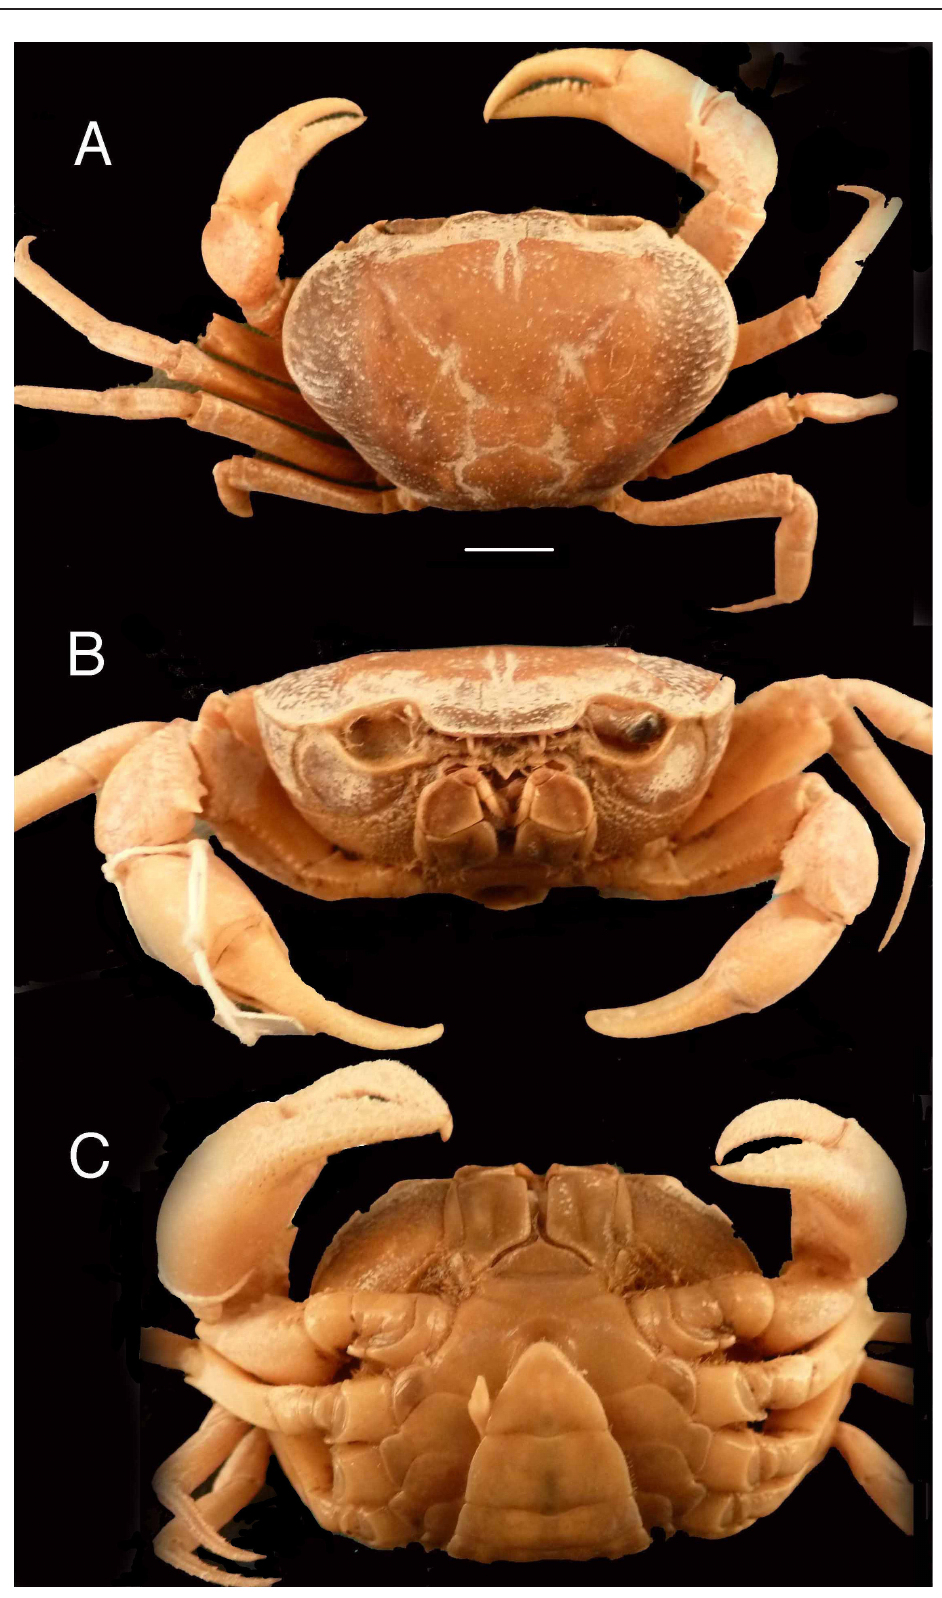
Fig. 3. Foza manonae sp. nov. Holotype, adult ♂, CW 43.7 mm, Ankarana Special Reserve, Madagascar (ZSM A20145003). Entire animal. A . Dorsal view. B . Frontal view. C . Sternal view. Scale bar: 14.6